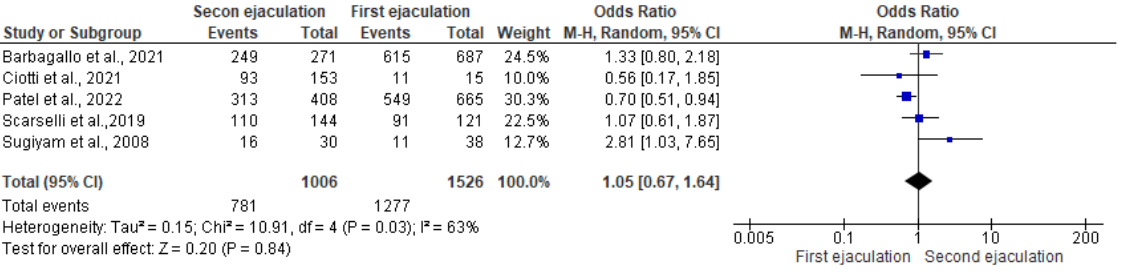
Figure 2. Forest plot showing the effects of a very short abstinence period on fertilization rate [28,30–33].